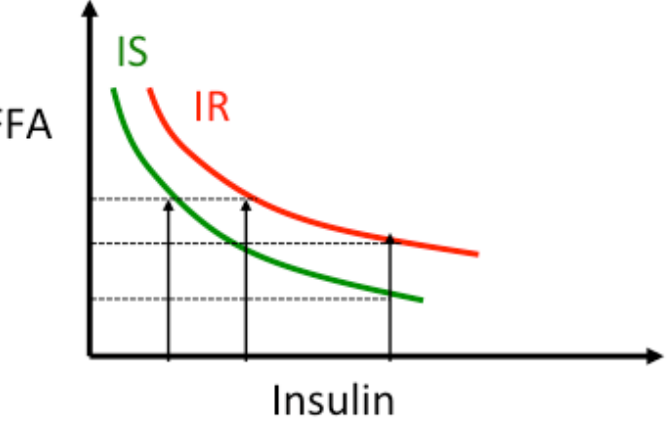
Figure 3. Relationship insulin-lipolysis. As insulin concentration increases, lipolysis, and thus plasma free fatty acids (FFA) concentration, is suppressed following a non-linear curve [65,69,70]. In presence of insulin resistance the curve is shifted to the right indicating that for the same insulin levels lipolysis is less suppressed and circulating FFA levels are higher. The product FFA × Insulin is used as an index of adipose tissue-insulin resistance.